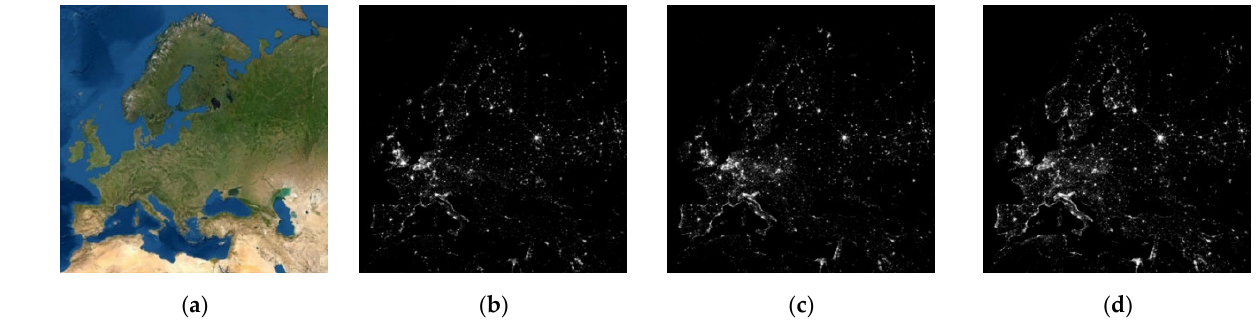
Figure 9. Daily energy and water consumption of mammals (data from [150]).